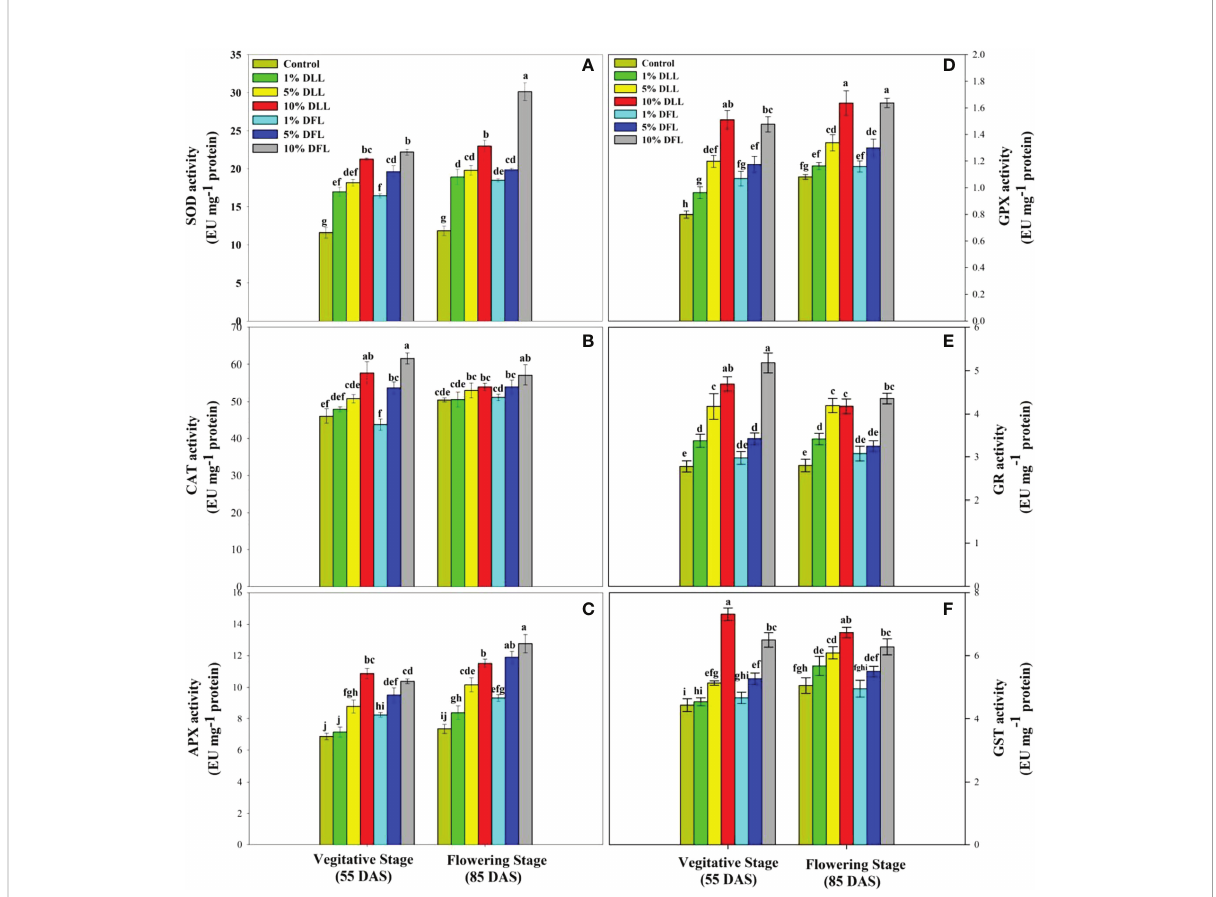
FIGURE 8 Superoxide dismutase, catalase, ascorbate peroxidase, guaiacol peroxidase, glutathione reductase, and glutathione S-transferase (EU mg -1 protein) activity (A – F) in fl ag leaves of Triticum aestivum L. raised using soil substrate at different developmental stages treated with leachates of dry leaves and fl owers of Tagetes erecta L. Data followed by the same letters are not signi fi cantly different at p<